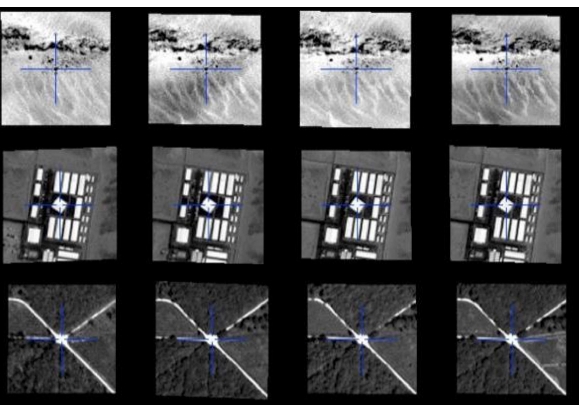
Figure 7. Examples of 3 GCP SRP points with 4 image chips There are two types of image chips at a fixed size of 101x101